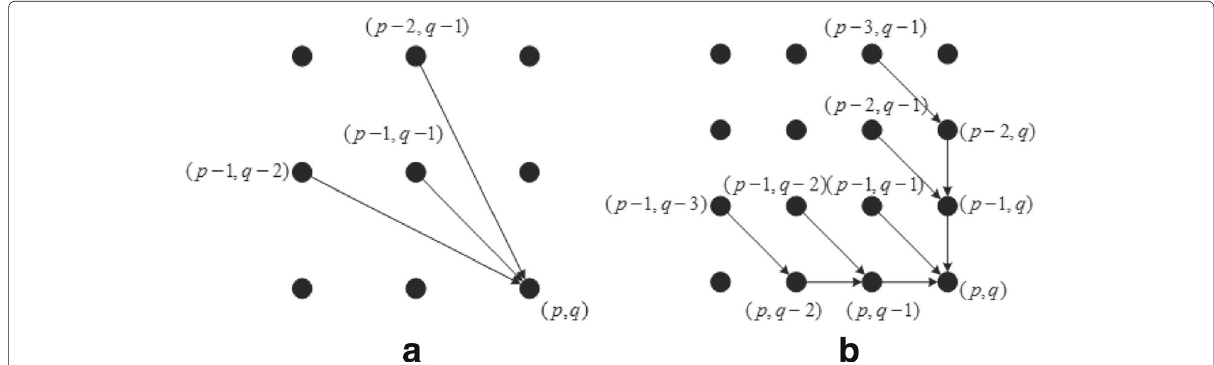
Fig. 2 Possible alignment constraints in the a Qmax and b